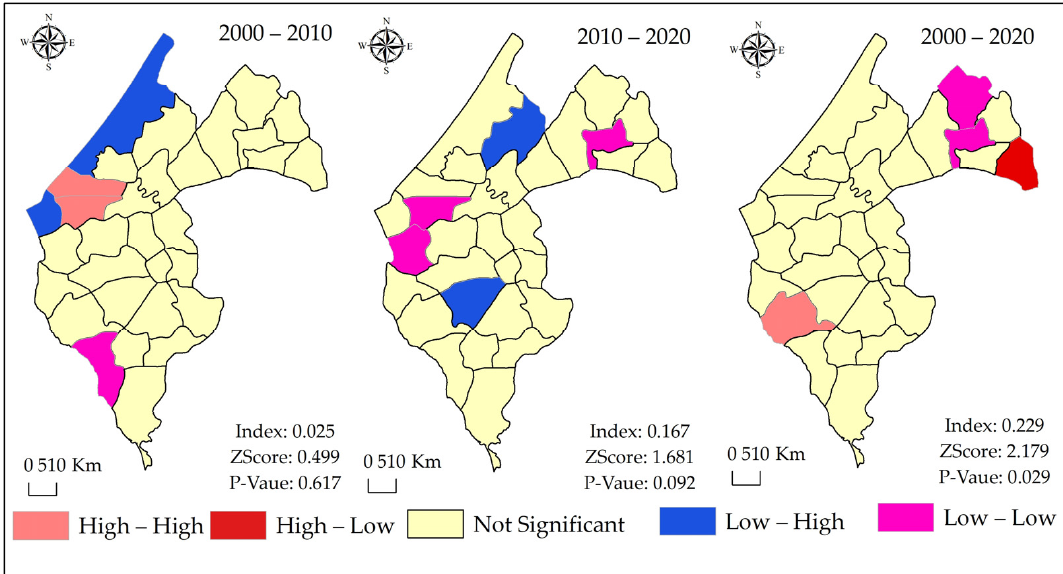
Figure 4. Hot pot analysis of agricultural land use transition (ALUT) .